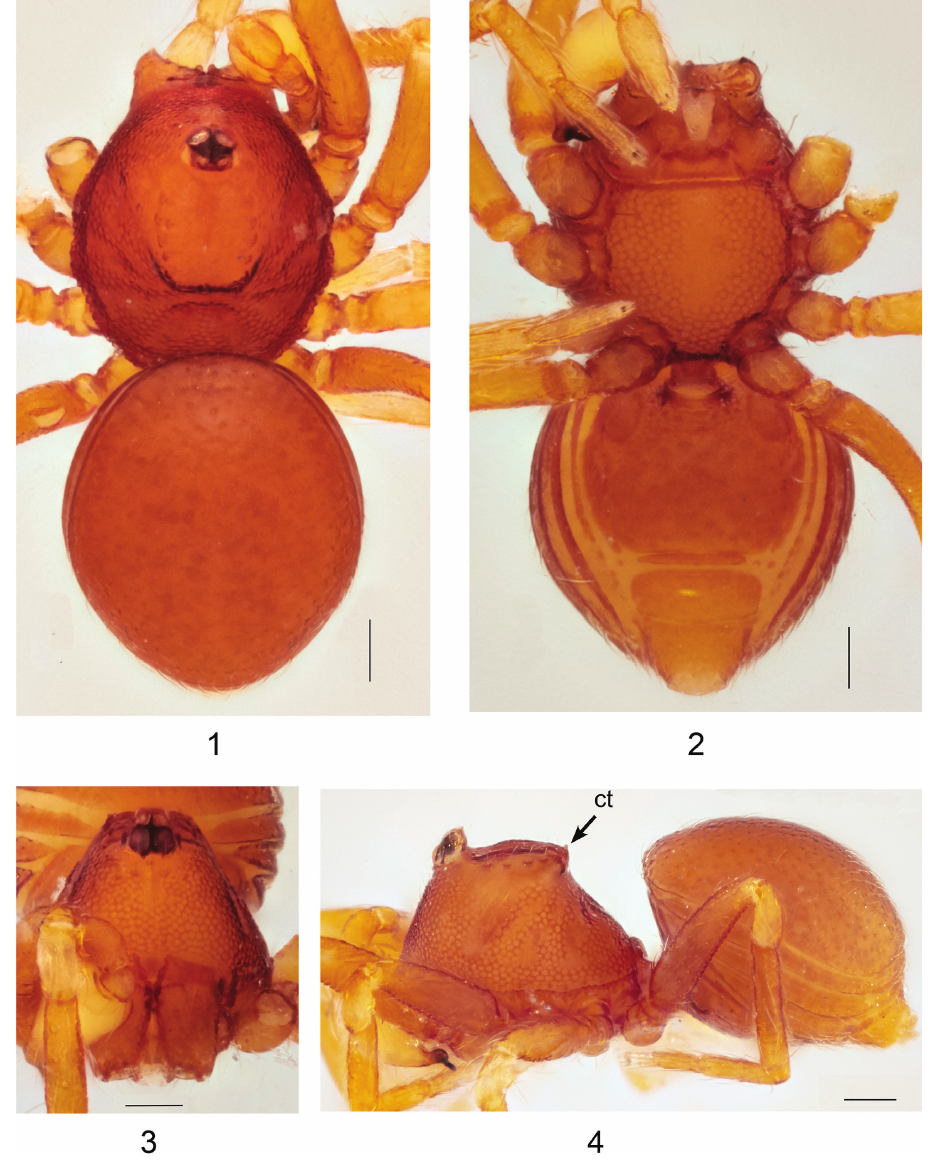
Figures 1–4. Ablemma andriana sp. n., male. 1 Habitus, dorsal view. 2 Habitus, ventral view. 3 Cara- pace, frontal view. 4 Habitus, lateral view. Scale bar: 1.0